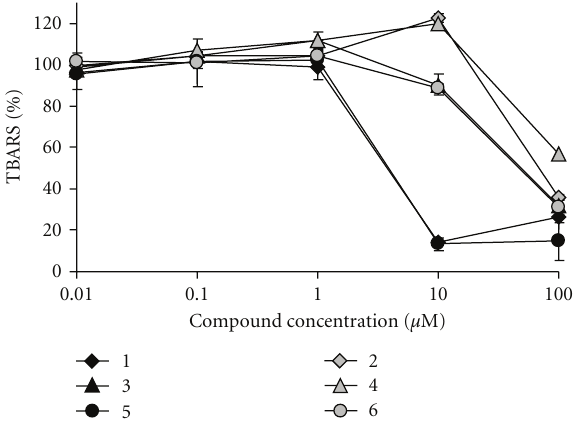
Figure 3: The relative content of TBARS in the lipid peroxidation of rat brain homogenates as nonenzymatic process in the presence